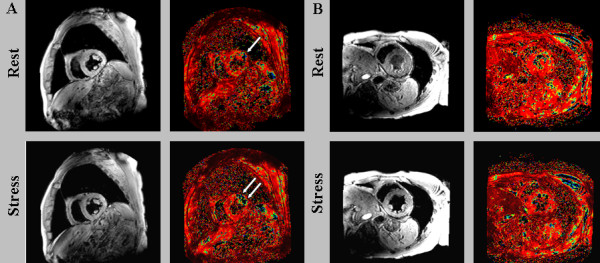
Imaging examples: Rest and stress BOLD CMR showing a patient with lateral ischemia (A) and a patient without coronary artery disease (B).